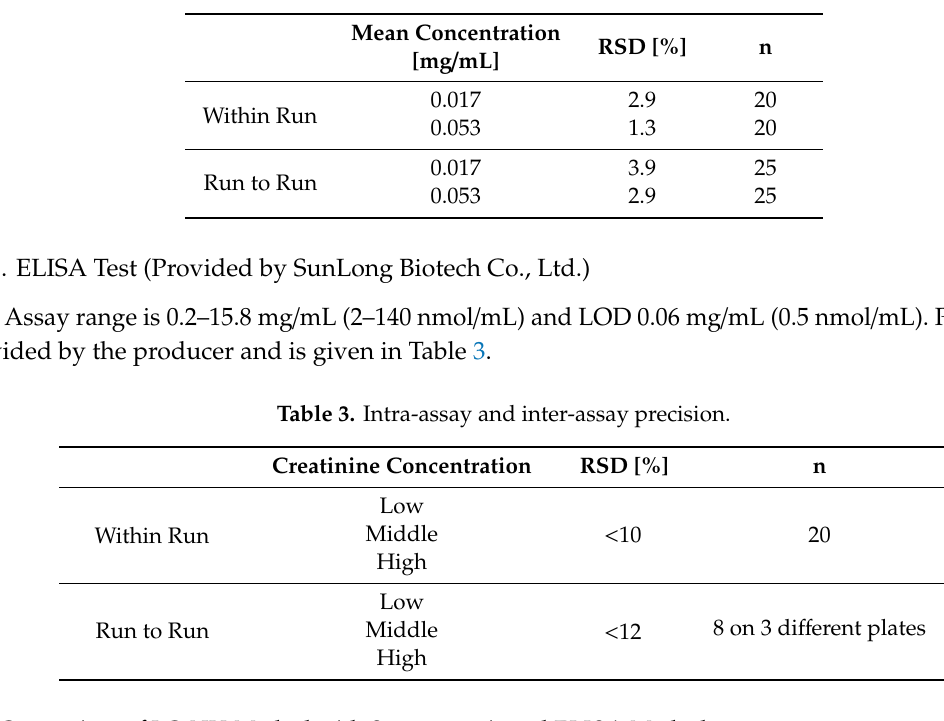
Table 2. Within run and run to run precision.